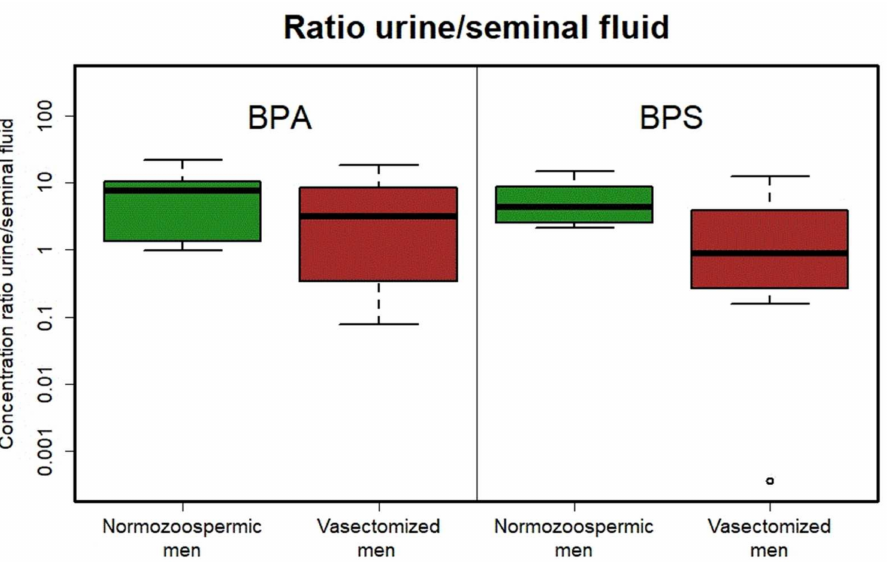
Figure 1. Boxplots of ratios between urinary and seminal plasma BPA ( left ) and BPS ( right ) concen- trations in normozoospermic (green) and vasectomized (red) patients. ◦ indicates patient outside the main